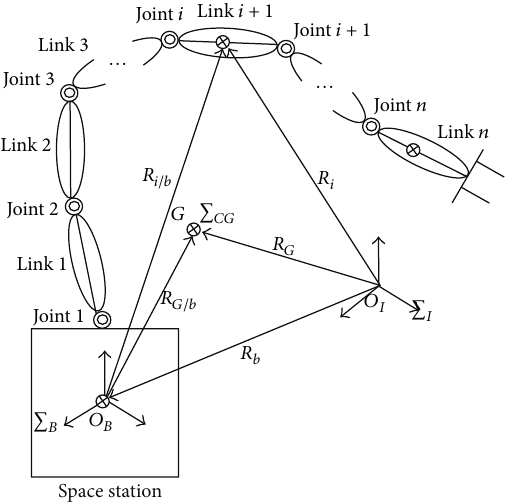
Figure 12: A general model of a space robotic